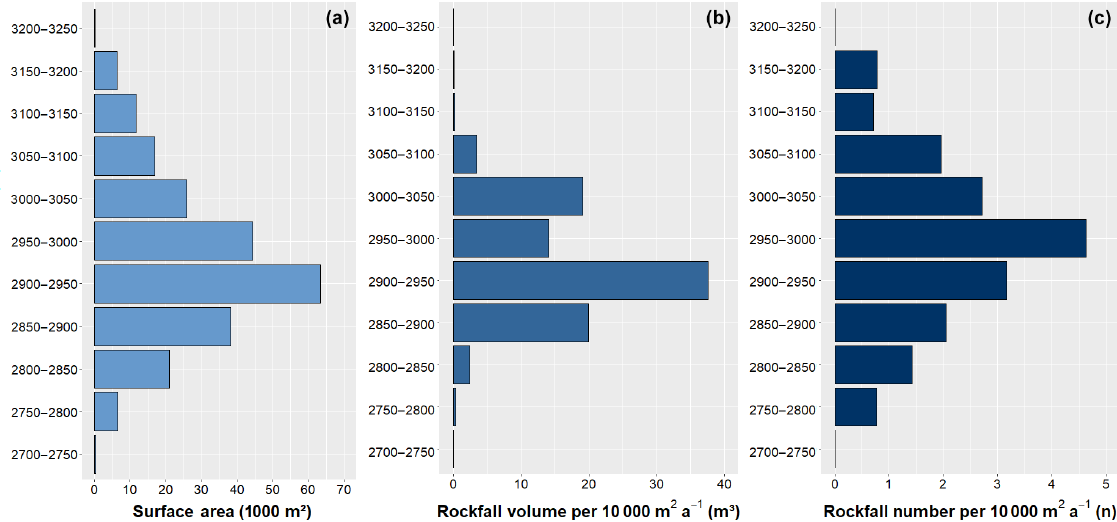
Figure 10. (a) Rockwall surface area, (b) normalized rockfall volume and (c) normalized number of rockfalls, all grouped by elevation in ma . s . l . A distinct peak in rockfall volume is observed between 2900 and 2950ma . s . l